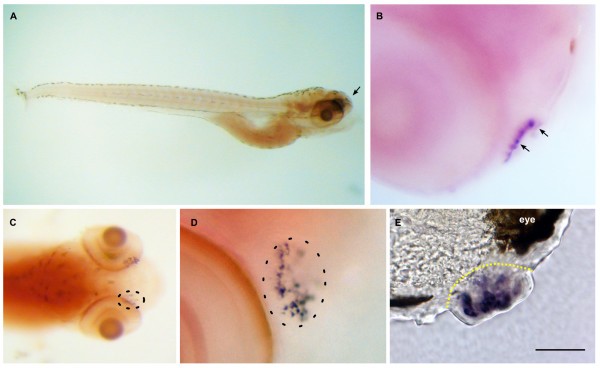
Dr-S100Z expression pattern by whole mount in situ hybridization. Five day old zebrafish larvae were hybridized with RNA antisense probe. Panels A) to D), whole mounts; panel E), sectioned after hybridization. Scale bar 30 μm. Lateral view. Expression in the larva is restricted to the olfactory placode (arrow). B) Closer view of the olfactory placode shows several large, labeled cells (arrows). C) Dorsal view of the head region, labeled cells in both olfactory placodes are visible, right placode encircled with dashed line. D) Enlarged view of a single olfactory placode (circled). Labeled cells are a subpopulation within the olfactory placode. E) Cross-section through an olfactory placode (delineated by yellow dashed line), several labeled cells are visible.